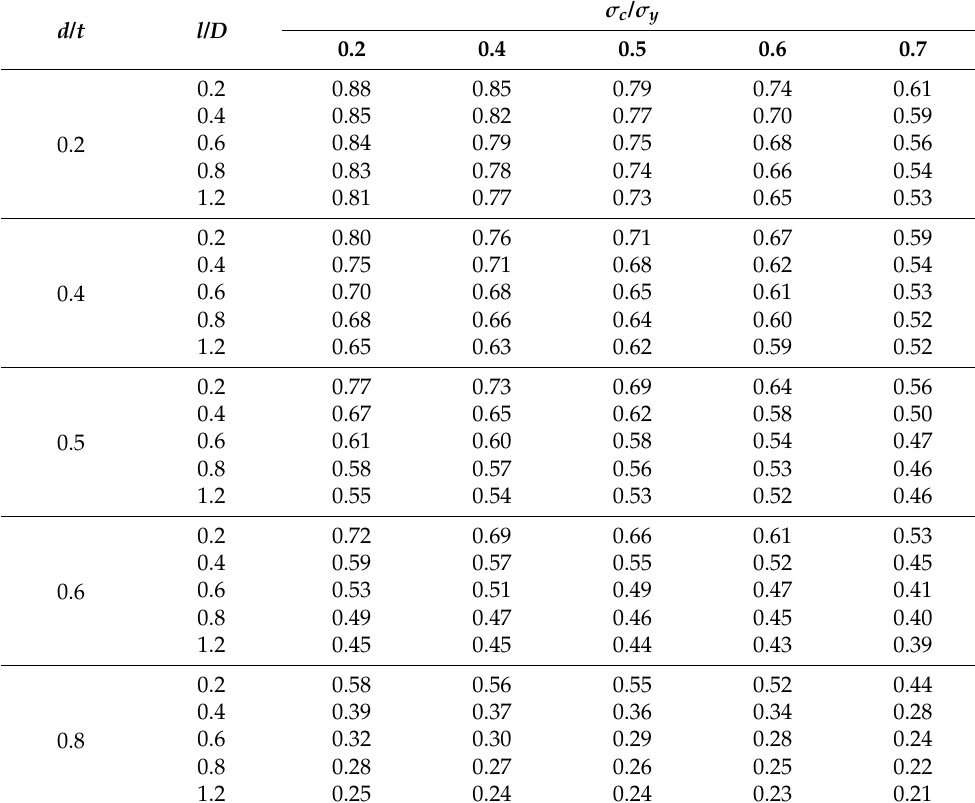
Table 6. FEA results of corroded X65 pipeline for ANN training dataset.